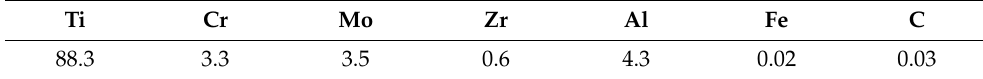
Table 1. Chemical compositions